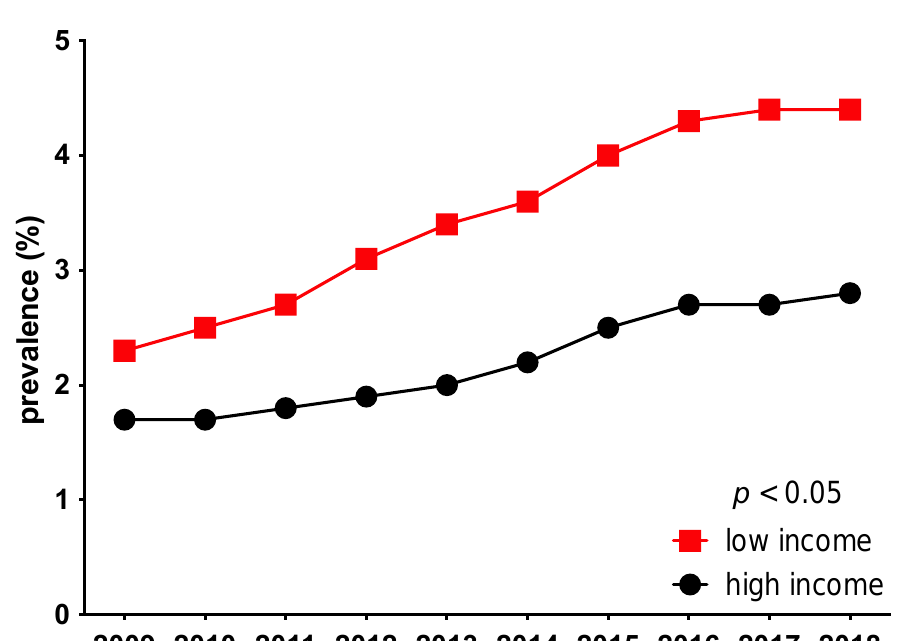
Figure 2. The prevalence of PAD increased during the 10-year study period, with a continuous higher prevalence in patients living in low-income areas compared with patients from high-income areas ( p < 0.05).